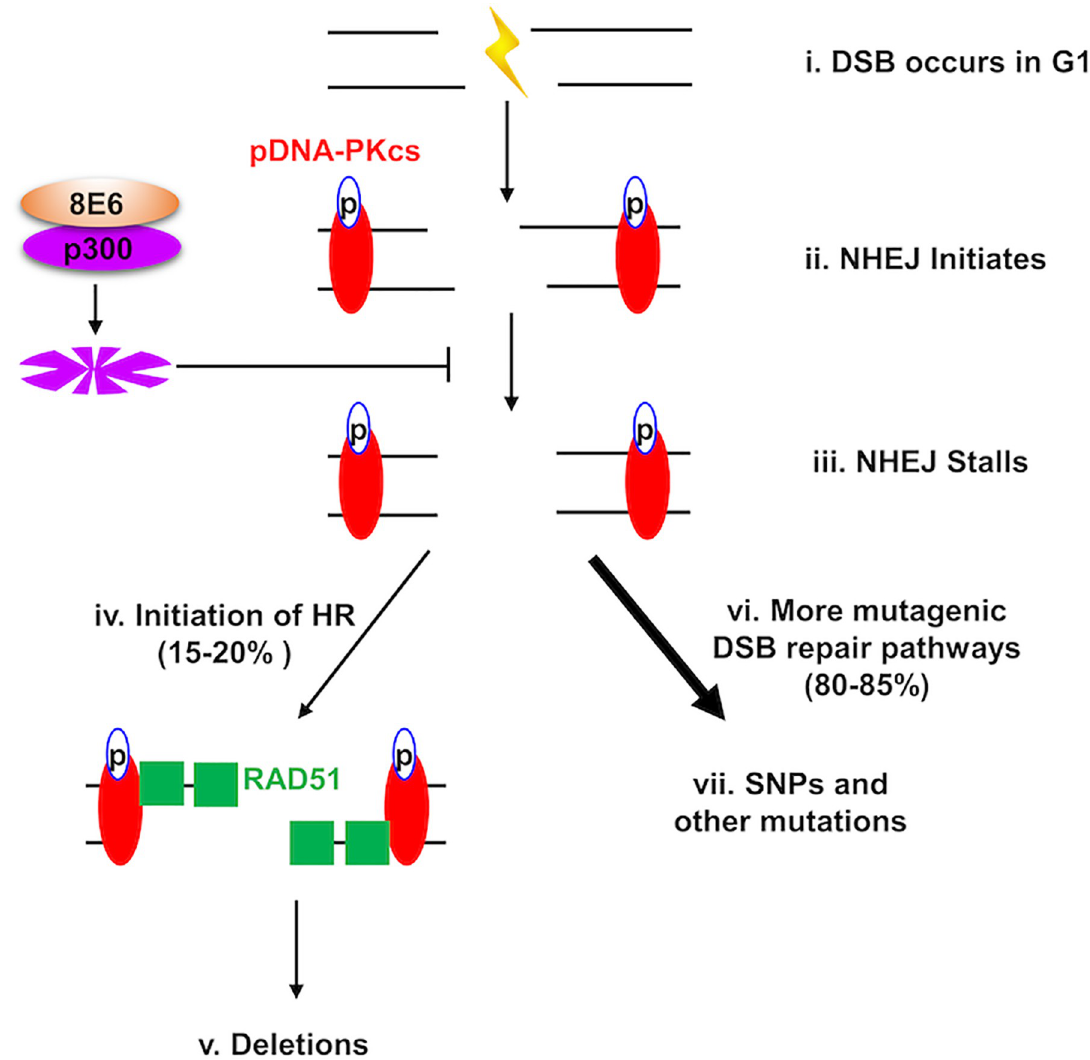
Fig 8. Summary figure of DSB repair in G1 phase. (i) DSB occurs in a cell in G1 phase that is expressing 8E6. (ii) NHEJ initiates. DNA-PKcs is recruited to the lesion where it is auto-phosphorylated. (iii) NHEJ stalls due to 8E6 mediated p300 degradation. This leaves unresolved pDNA-PKcs repair complexes [9]. (iv) HR initiates at the site of failed NHEJ. The MRN complex, CtIP, and EXO1 resect one strand of DNA near the lesion, producing single stranded DNA [73]. RPA complexes coat and stabilize the resulting single stranded DNA [39]. RPA70 foci colocalize with pDNA-PKcs indicating that HR-mediated DNA resection occurs after NHEJ fails. Then, RAD51 is recruited to the break site. (v) HR cannot be complete due to the lack of a homologous template and/or 8E6-mediated inhibition of HR [7]. This causes deletions due to antagonist DNA end process by NHEJ and HR and/or by failure to complete HR after resection. (vi) The failure of NHEJ causes cells to use tertiary DSB repair pathways to fix the lesion. (vii) This alternative repair pathway (e.g., Alt-EJ) is error prone and increases other types of mutations (such as